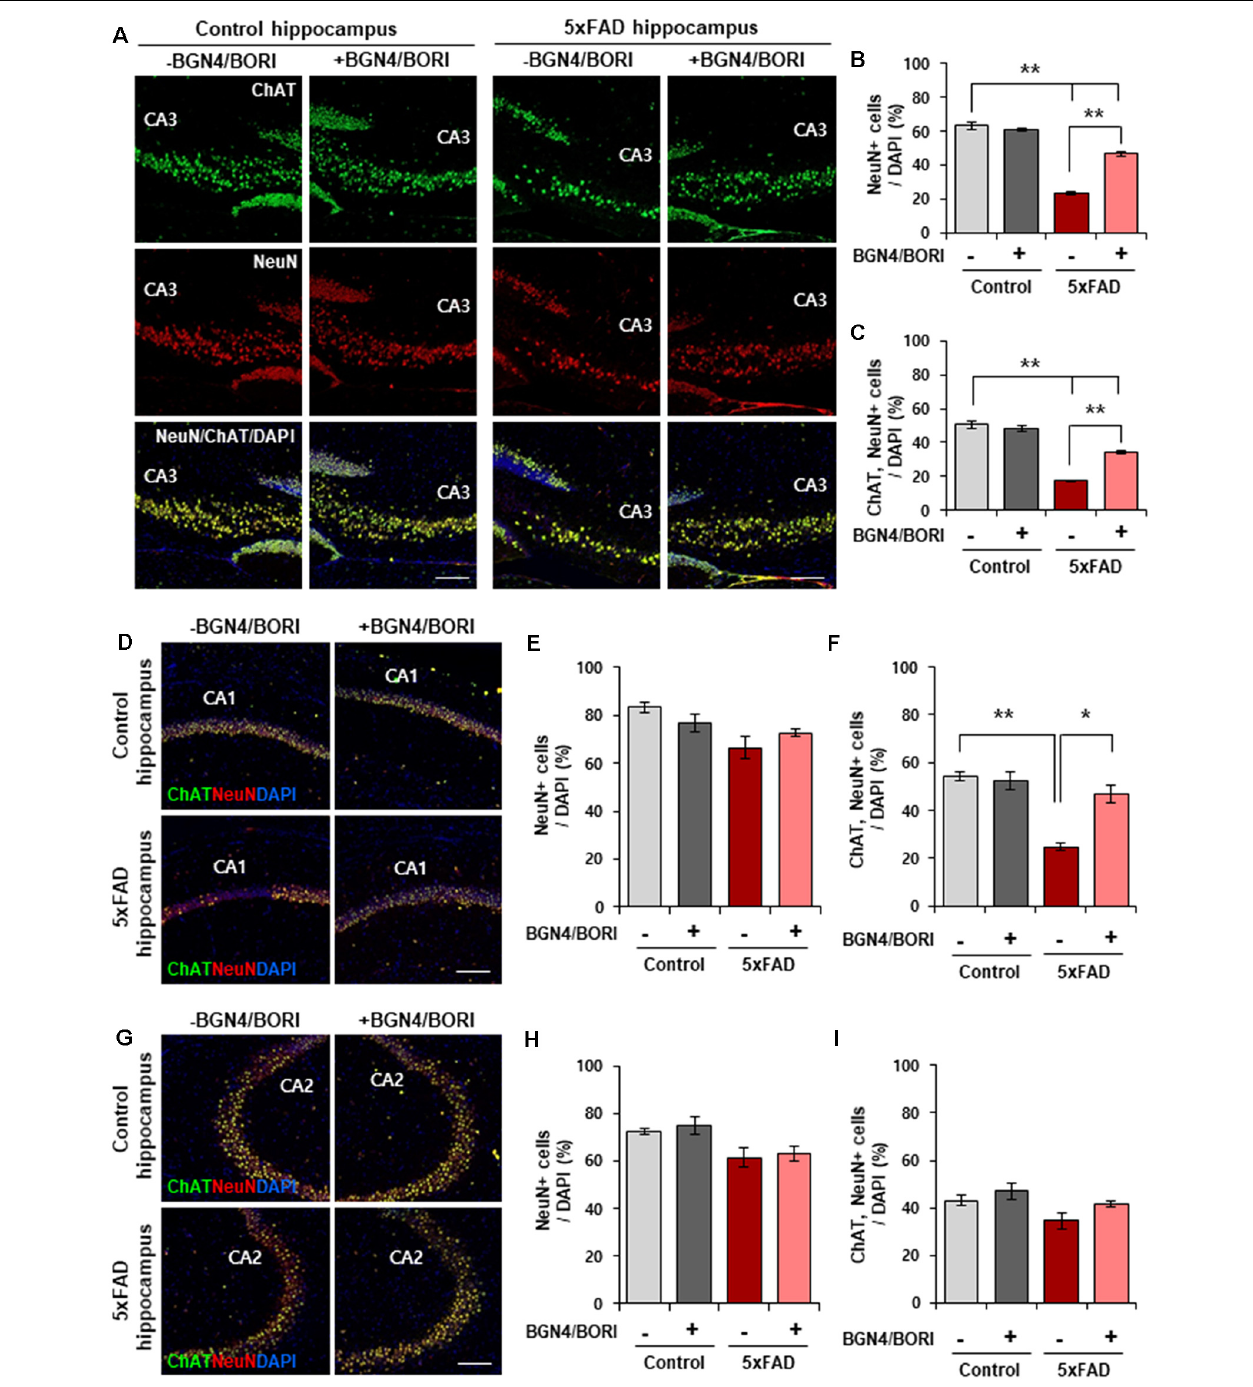
FIGURE 1 | B. bifidum BGN4 and B. longum BORI reduced hippocampal neuronal death in 5xFAD Mice. (A) Immunofluorescence for ChAT and NeuN positive cells in the CA3 hippocampal subfields of control (left) or 5xFAD mice (right) treated with B. bifidum BGN4 and B. longum BORI (BGN4/BORI). Scale bar = 50 µ m. (B,C) Quantifications of the NeuN+ (B) and ChAT+/NeuN+ (C) neurons in the CA3 region at 30 days. Data represent the mean ± SEM. ANOVA , ** p < 0.01 ( n = 5). (D) Representative images of ChAT and NeuN positive cells in the CA1 hippocampal subfields of control or 5xFAD mice treated B. bifidum BGN4 and B. longum BORI. Scale bar = 50 µ m. (E,F) Quantifications of the NeuN+ (E) and ChAT+/NeuN+ (F) neurons in the CA1 hippocampal region at 30 days. Data represent the mean ± SEM. ANOVA , * p < 0.05, ** p < 0.01 ( n = 5). (G) Representative images of ChAT and NeuN positive cells in the CA2 hippocampal subfields of control or 5xFAD mice treated B. bifidum BGN4 and B. longum BORI. Scale bar = 50 µ m. (H,I) Quantifications of the NeuN+ (H) and ChAT+/NeuN+ (I) neurons in the CA2 hippocampal region at 30 days. Data represent the mean ± SEM ( n = 5).